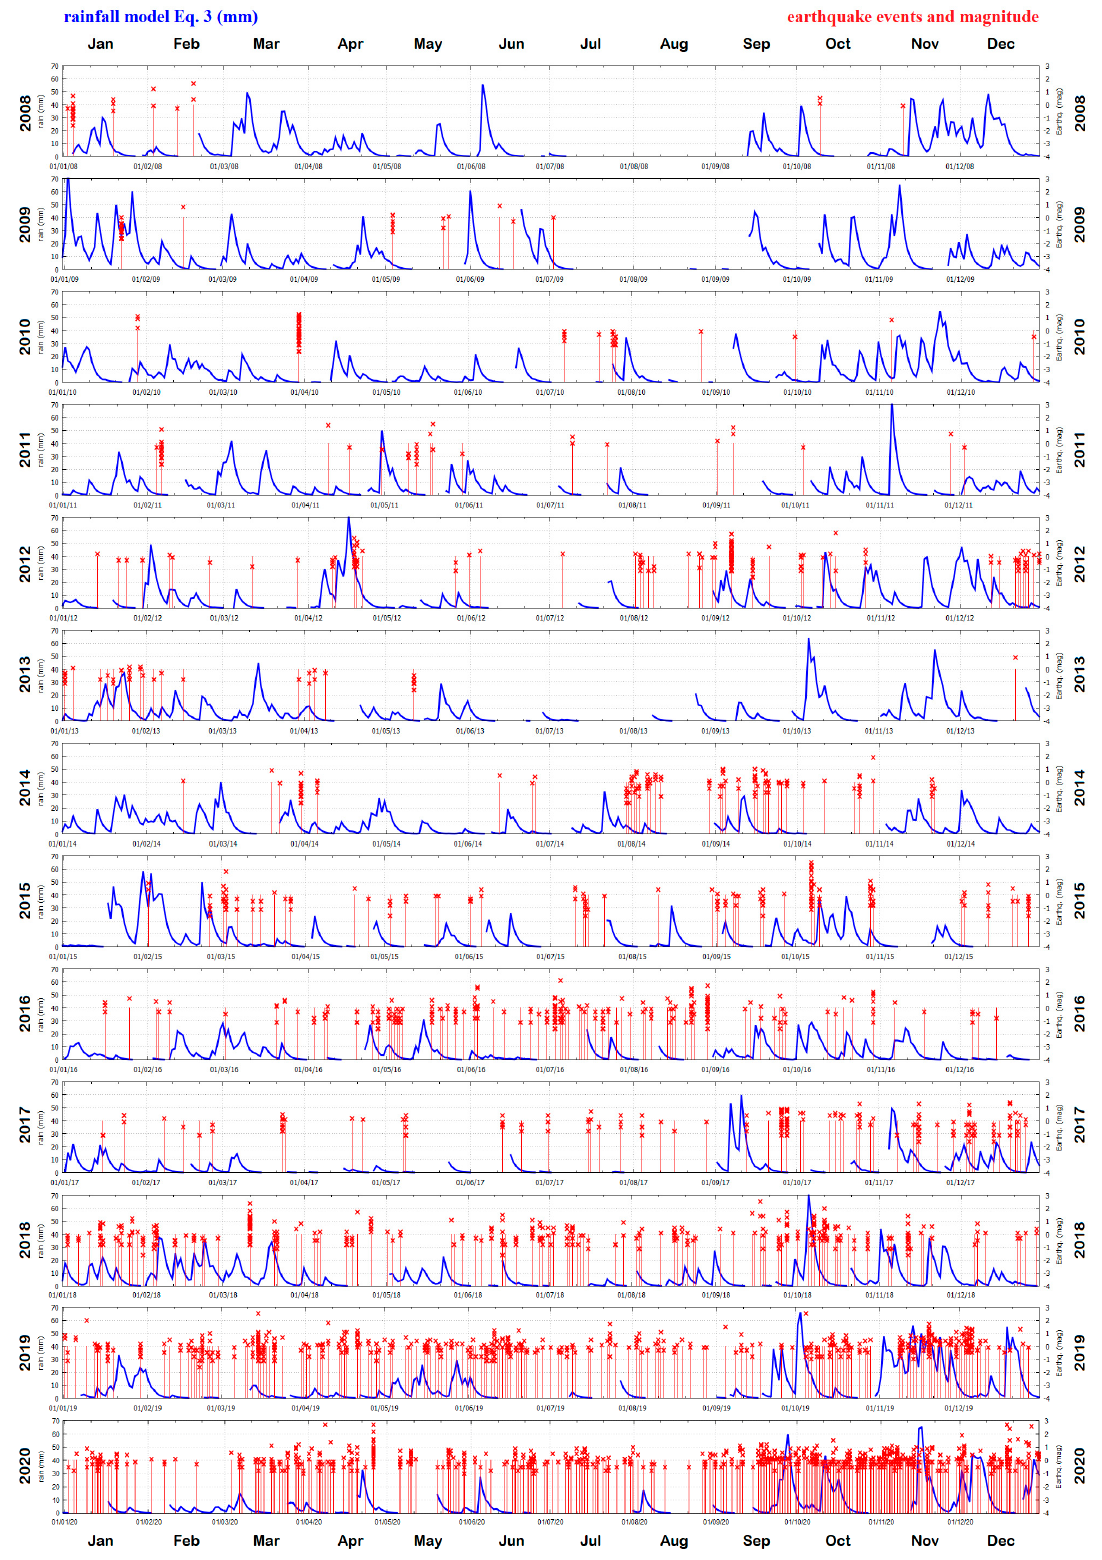
Figure 5. Scenario #4: R = 0.1 mm and τ = 2 day. Comparison between the empirical water stress-function (Equation (3)) estimated with the rainfall record of the Meteorological Observatory at San Marcellino in Naples (blue) and the seismic events at the Phlegraean Fields from 2008 to 2020 (red). Each panel covers one year. See Table 4.